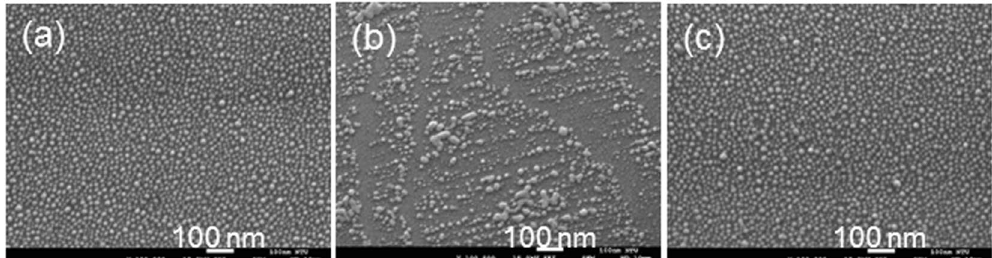
Figure 8. ( a–c ) SEM images of a fresh Ag NP sample on a Si-face 4H-SiC template, the Ag NP structures after the illuminations of 395- and 367-nm LEDs, respectively, for 16 hours in